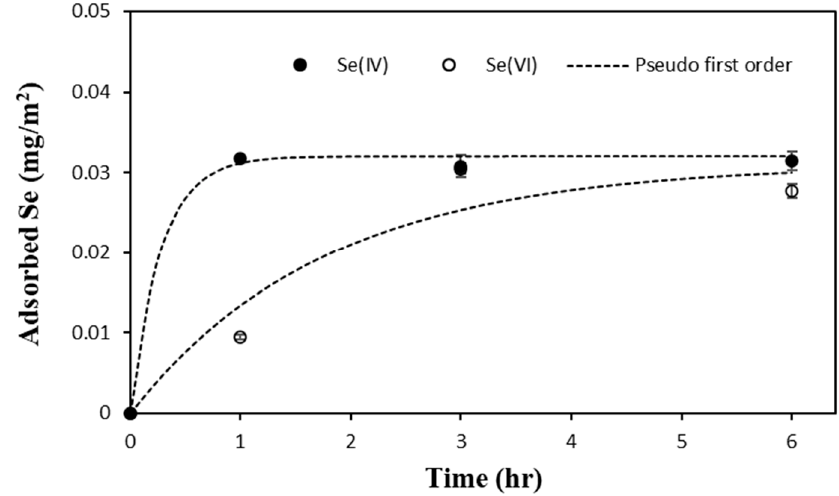
Figure 6. Adsorption capacity of the LFCM for Se(IV) and Se(VI).